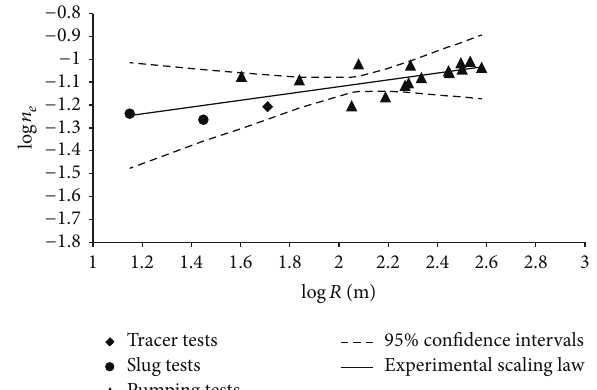
Figure 10: Trend of effective porosity versus scale for all field data